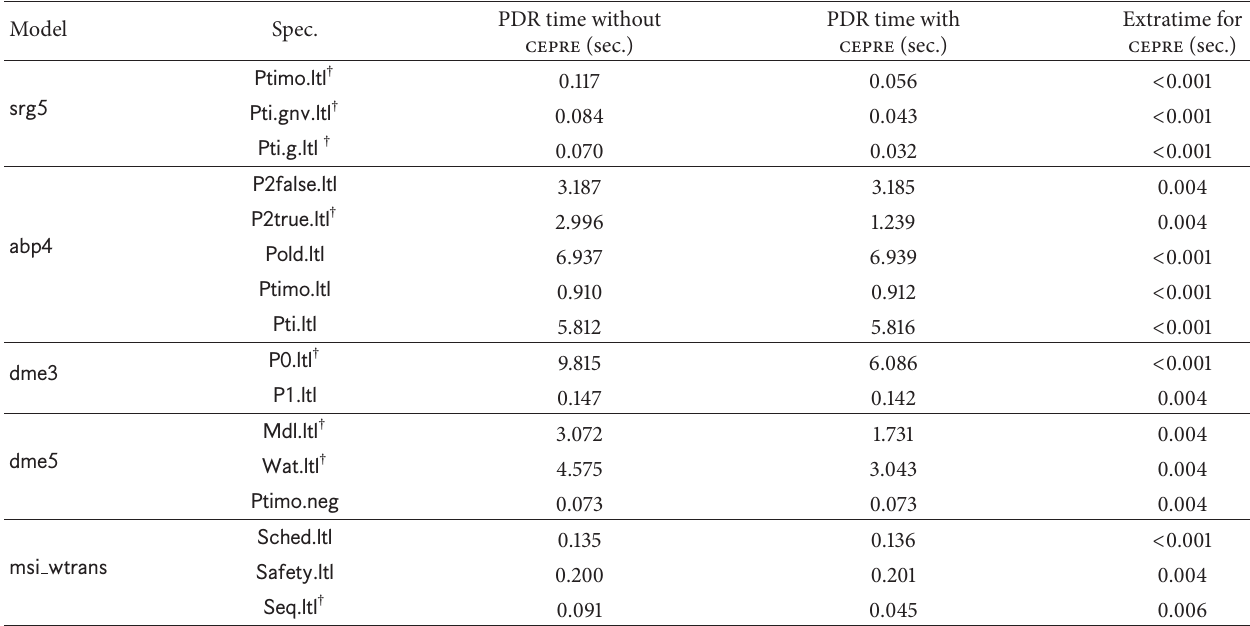
Table 11: Experimental result of PDR-based MC with/without